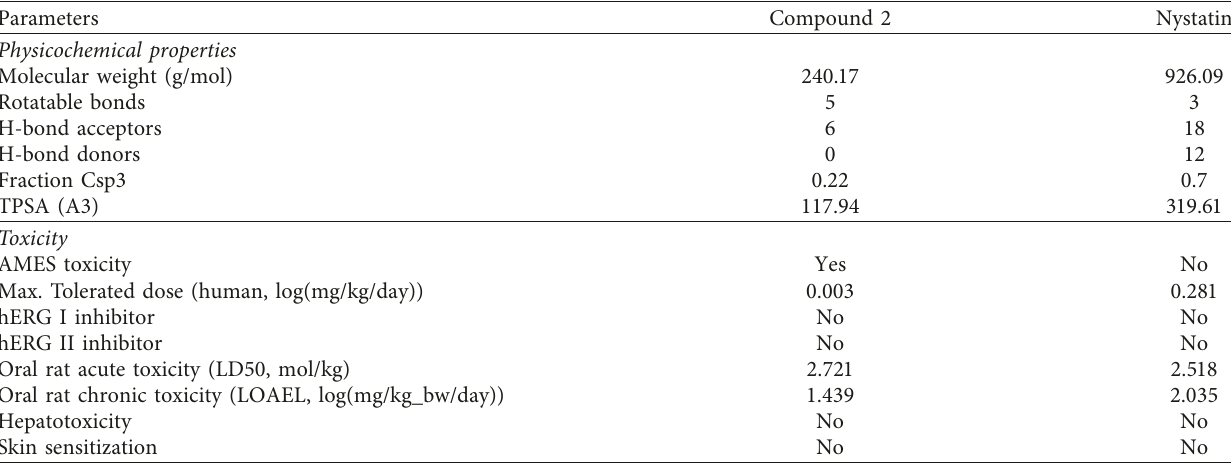
Figure 4: Surface representation of the region of the potential targets of compound 2 interacting with its ethyl group. Table 4: Physicochemical and ADMET predictions for compound 2 and